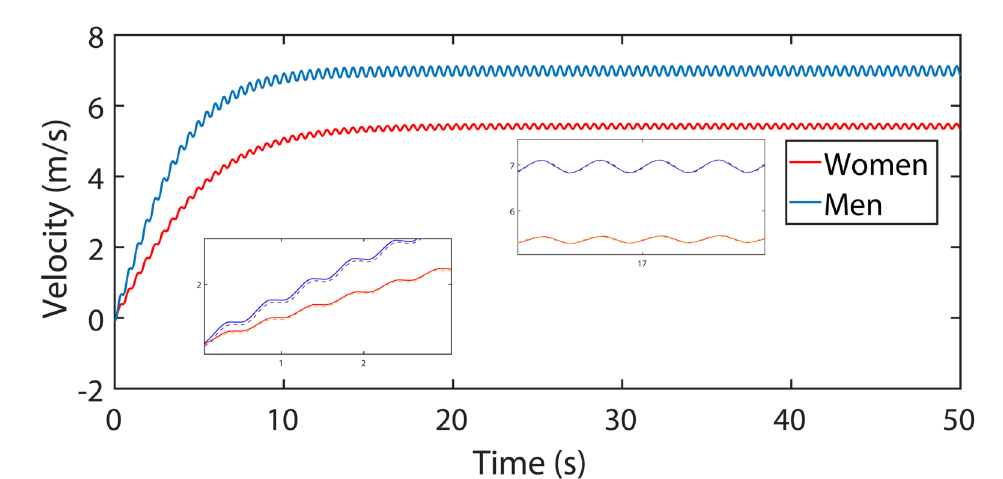
Figure 9. Analytical solution for maximum frequency and quadratic stroke: women and men. In detail, the comparison with the numerical solution (in dashed line) for both cases and both in the initial transient and in the final part of the